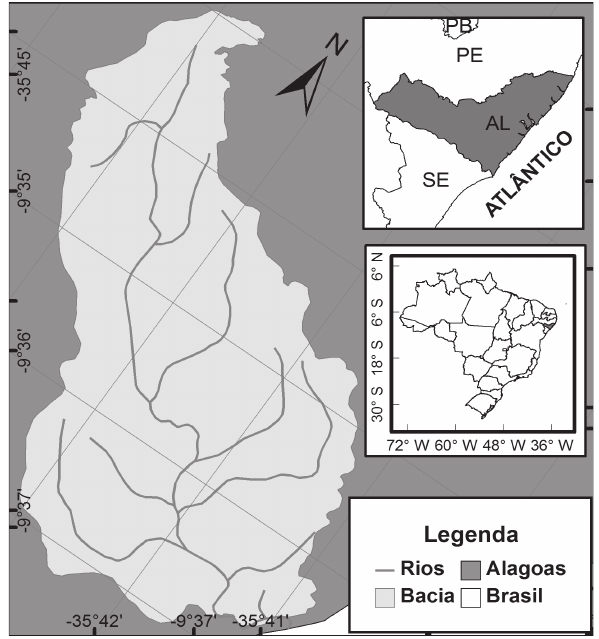
Figura 1. Localização da bacia do rio